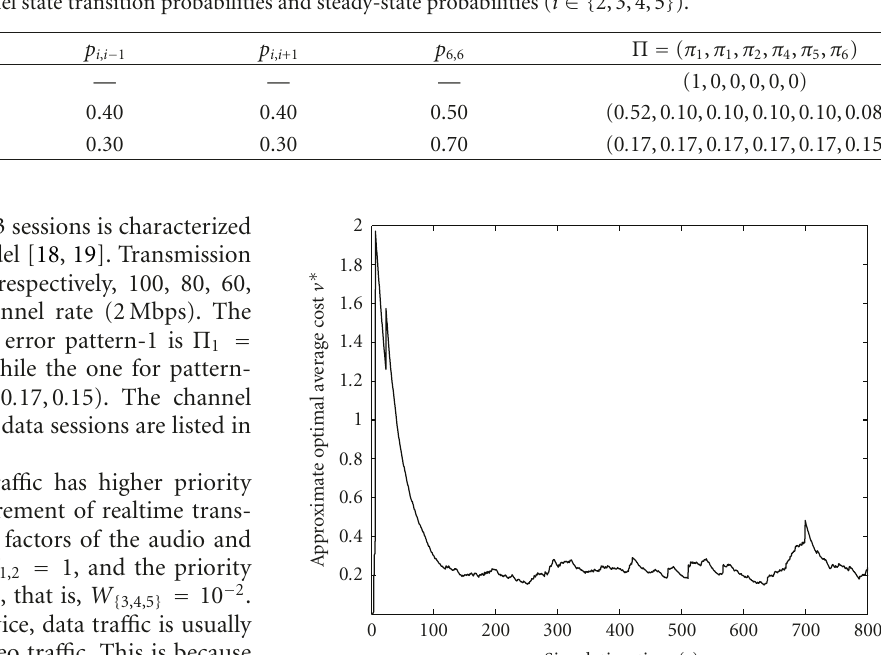
Table 2: Channel state transition probabilities and steady-state probabilities ( i ∈ { 2,3,4,5 } ).